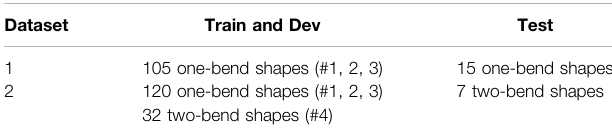
TABLE 2 | The compositions of the